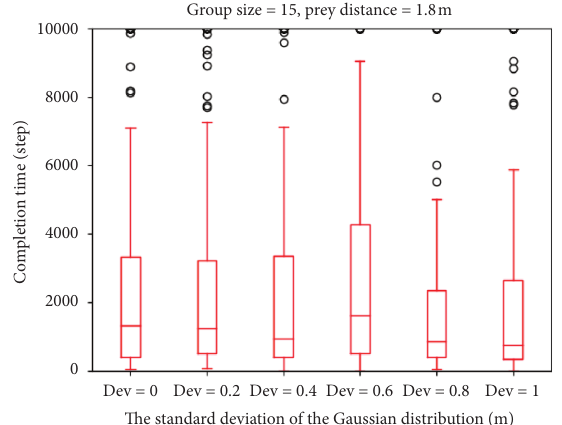
Dev = 0 Dev = 0.2 Dev = 0.4 Dev = 0.6 Dev = 0.8 Dev = 1 Figure 15: Box-and-whisker plots (Becker et al. 1998 [41]) of robustness tests for direction perception in the range-and-bearing system (100 observations per box) for a group of 15 robots and a food distance of 1.8 m. See Figure 10 for an explanation of box-and- Figure 17: Box-and-whisker plots (Becker et al. 1998 [41]) of whisker plots. robustness tests for the differential steering of the robot wheels (100 observations per box) for a group of 15 robots and a food distance of 1.8m. See Figure 10 for an explanation of box-and-whisker